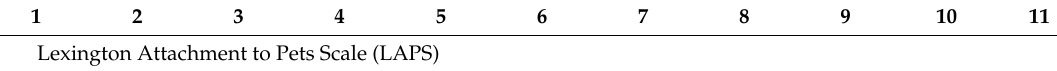
Table 2. Descriptive statistics and correlations between all constructs ( N =